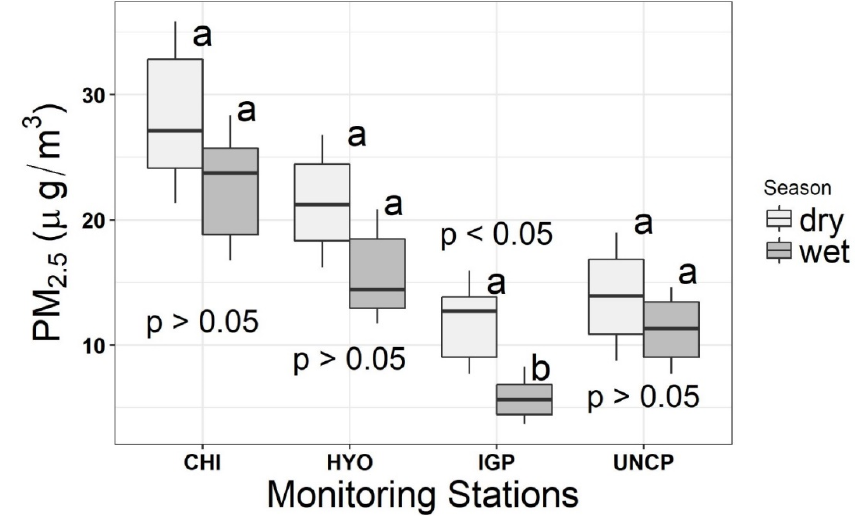
Figure 3. Boxplot mean mass concentration ± standard deviation (S.D.) of PM 2.5 at each monitoring station for the dry season (May to September) and the wet season (March, April, October, and November). Means with the same letter (a and b) code are not significantly different (Tukey multiple comparisons of means, p <